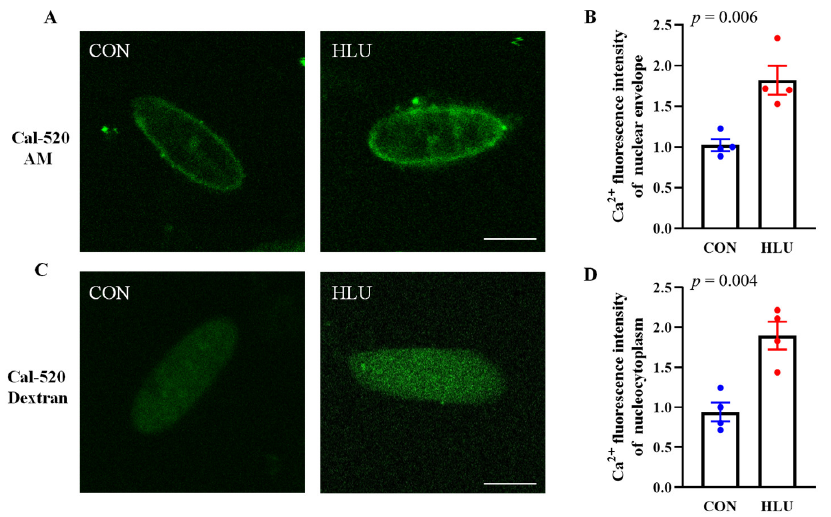
Figure 3. Free Ca 2+ levels in nuclear envelope and nucleocytoplasm. ( A ) Free Ca 2+ in nuclear envelope was showed by loading Cal-520 AM. ( B ) Change in Ca 2+ fluorescence intensity in nuclear envelope. ( C ) Free Ca 2+ in nucleocytoplasm was showed by loading Cal-520 Dextran. ( D ) Change in Ca 2+ fluorescence intensity in nucleocytoplasm. Each circle represented a value. Observe at least 10 nuclei per individual. n = 4. Data were analyzed by t -test. Data are shown as Mean ± SEM and considered statistically significant at p < 0.05. Scale bar, 5μm.